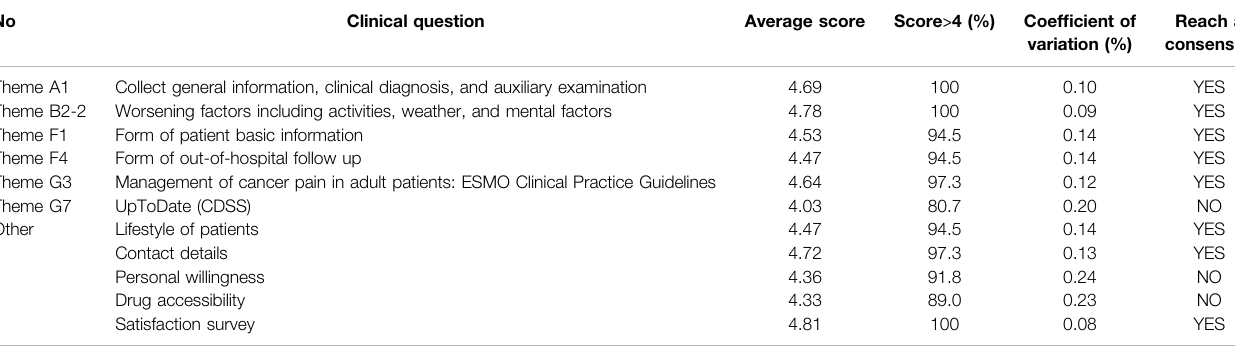
TABLE 3 | Clinical questions of the second round.